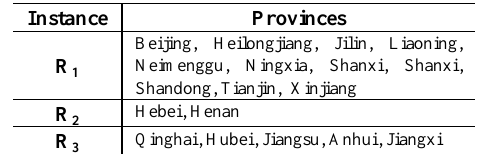
Table 2. the detailed result of